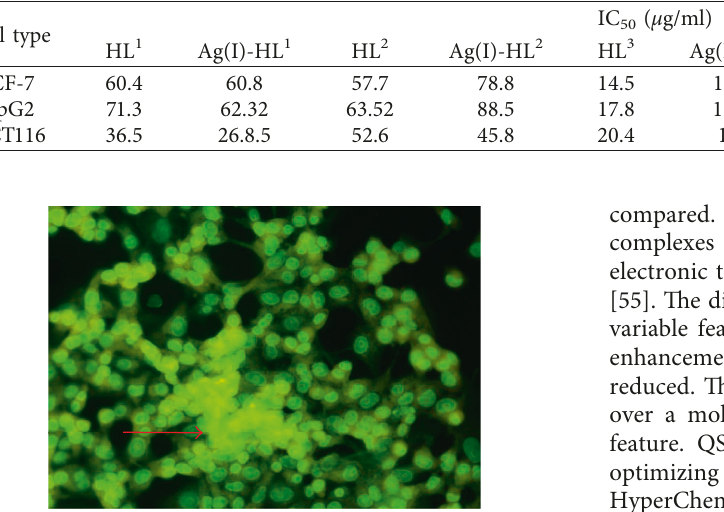
Table 4: Cytotoxic activity of tested complexes against human cancer cell lines.